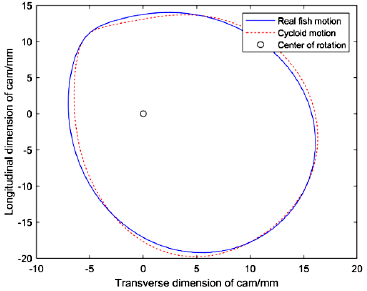
Figure 2. The two cam profiles for achieving real fish motion and cycloid motion.